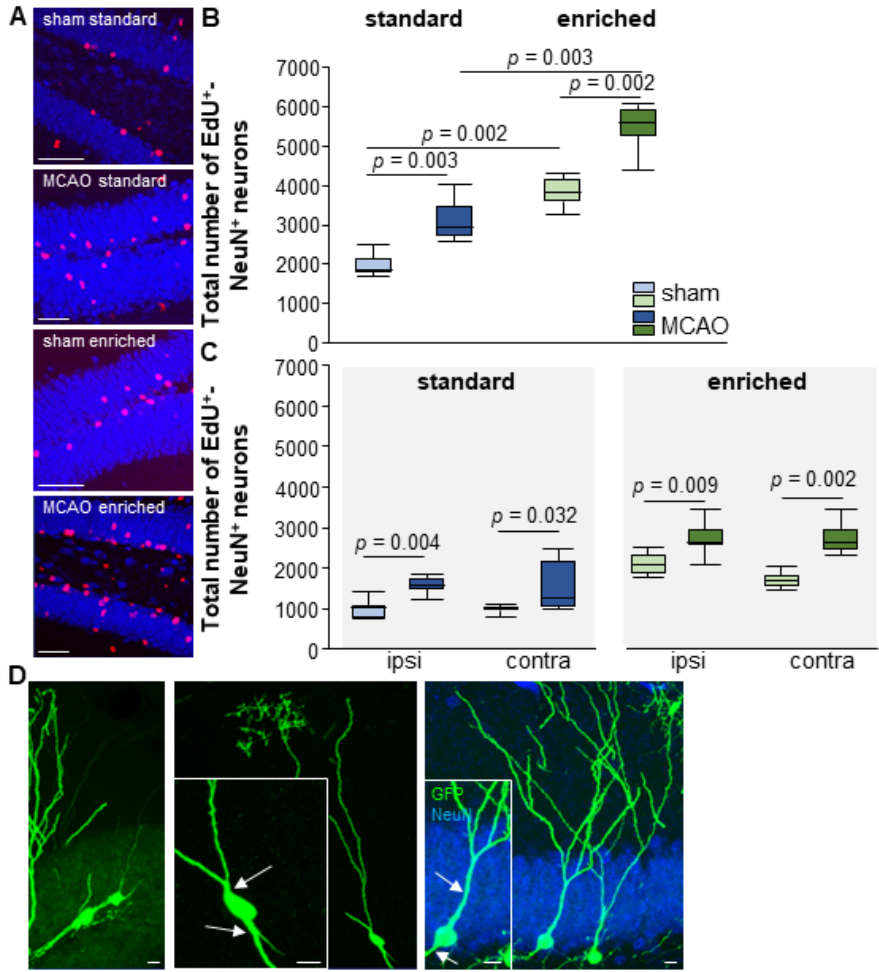
Figure 5. Stroke and EE-induced neurogenesis. ( A , B ) MCAO induction significantly increased new neuron formation 7 weeks later. EE significantly increases the number of newly generated neurons in both sham and MCAO mice. ( C ) This increase occured ipsi- and contralaterally in all groups. The boxplots show the median, upper and lower quartile, and minimum and maximum values. Statistical analysis was performed using the Mann-Whitney U test, scale bar = 50 µ m. ( D ) Aberrant GFP-labelled new neurons with two dendritic trees (white arrows), one dendritic tree extending into the hilus (GFP green, NeuN blue). Scale bar = 10 µ m. For the morphological analyses of the newly born neurons, we determined the following numbers of cells: MCAO-SD n = 20; MCAO-sham n = 28; MCAO-EE n = 24; sham-EE n = 9. Scale bar = 10 µ